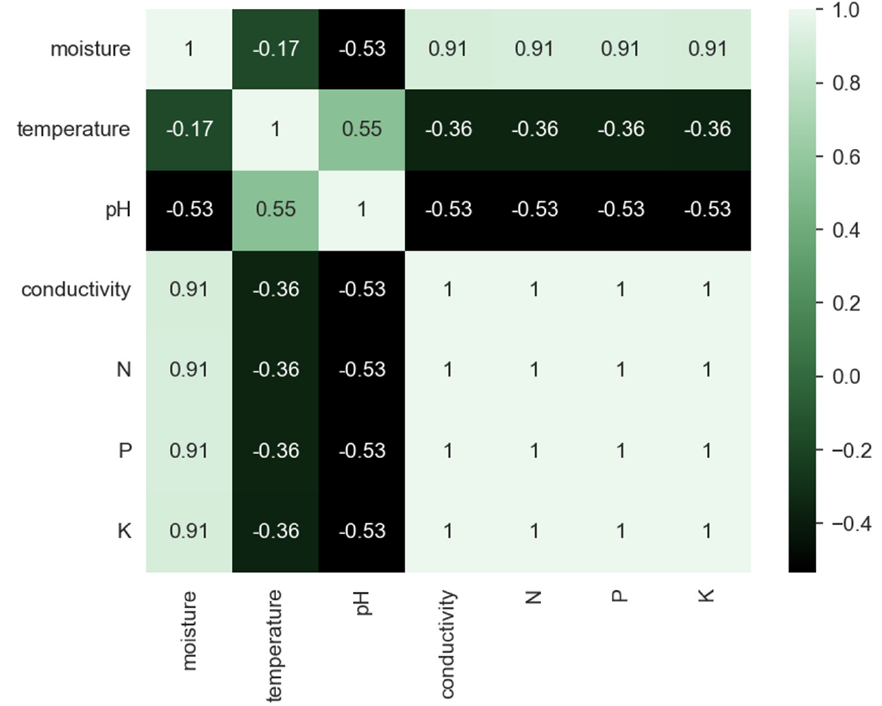
Figure 17. Correlational matrix for soil parameters from values collected before precipitation (where the cell colors correspond to the scale presented on the right side where negative values correspond to dark green and positive values to light green).